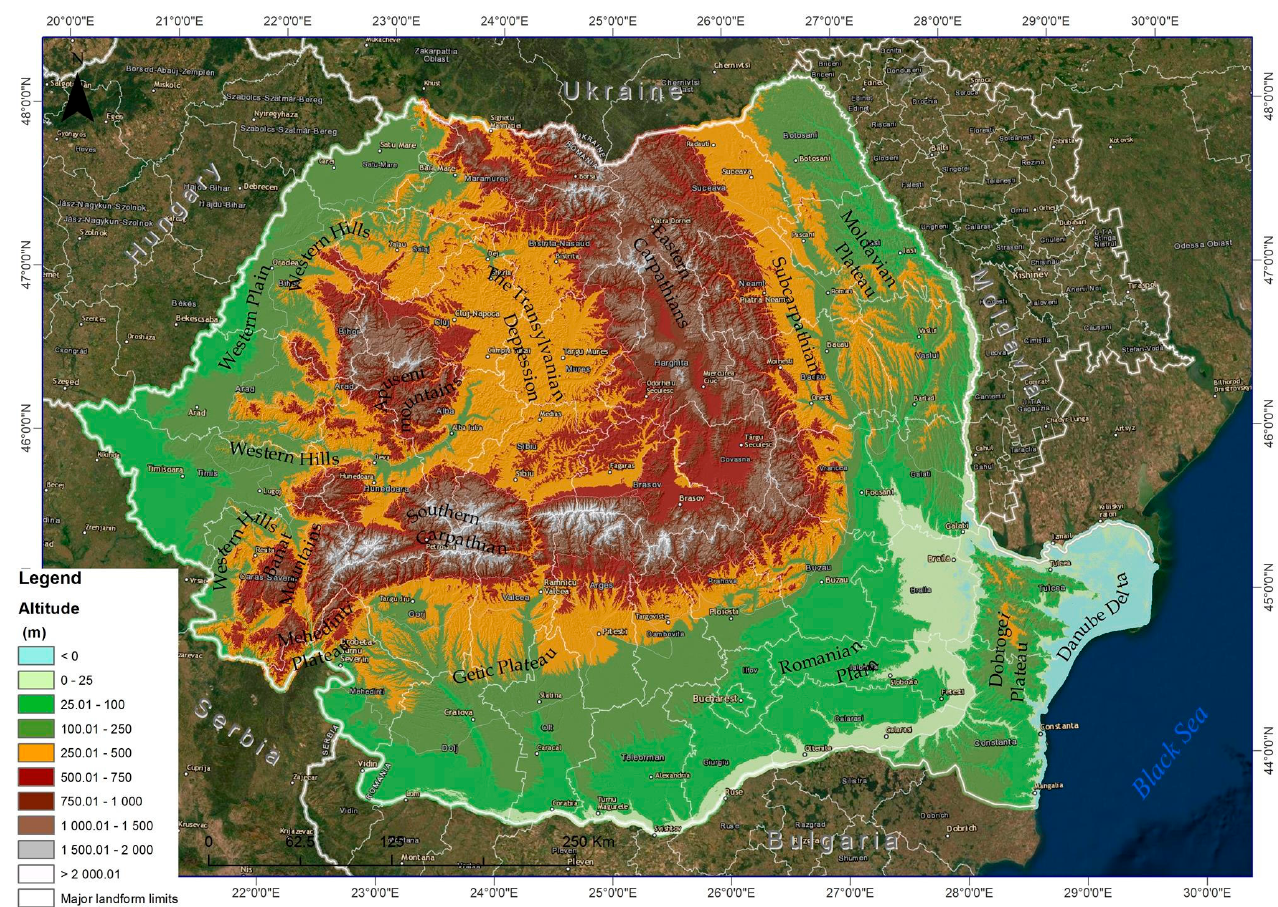
Figure 1. Location of Romania and major